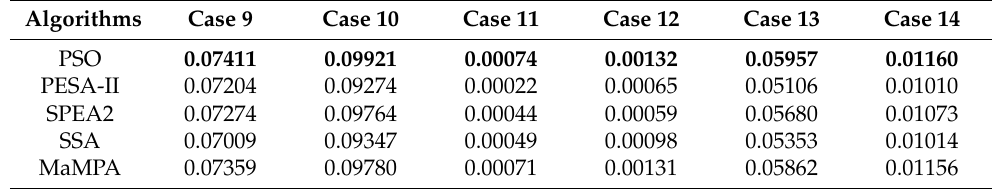
Table 11. Hypervolume comparison of multi-objective OPF (MOOPF) problems in the IEEE 30-bus system.